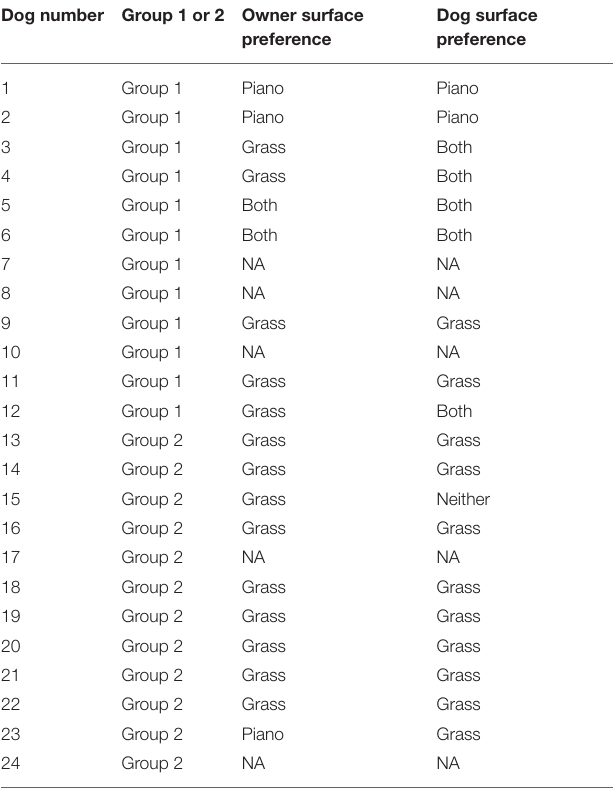
TABLE 3 | Owner and dog surface preference stratified by group